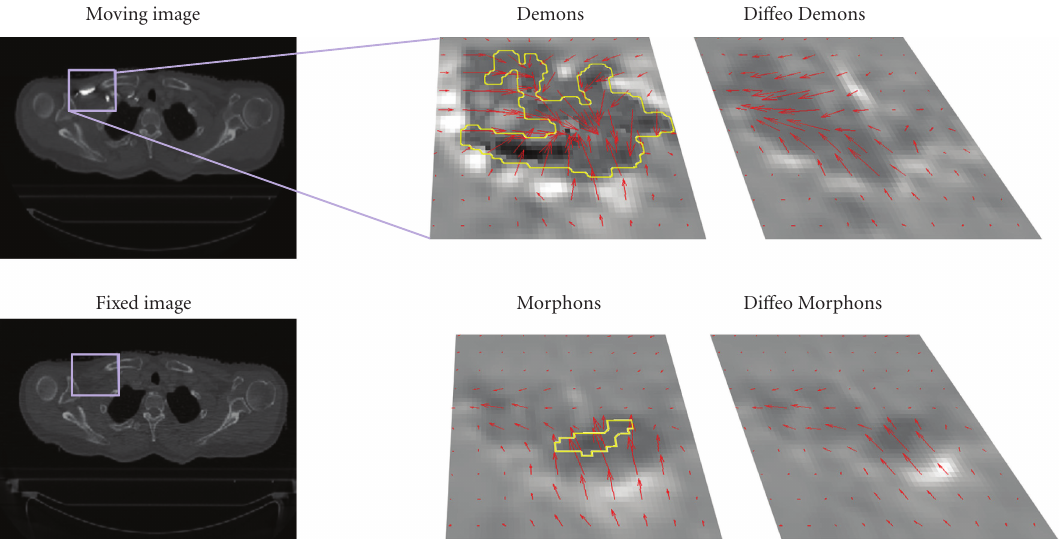
Figure 9: Illustration of negative Jacobians resulting from nondi ff eomorphic registrations. Left: moving and fixed images. Right: fields resulting from registrations (red arrows) and their Jacobian (grayscale images). The negative Jacobians regions are contoured in